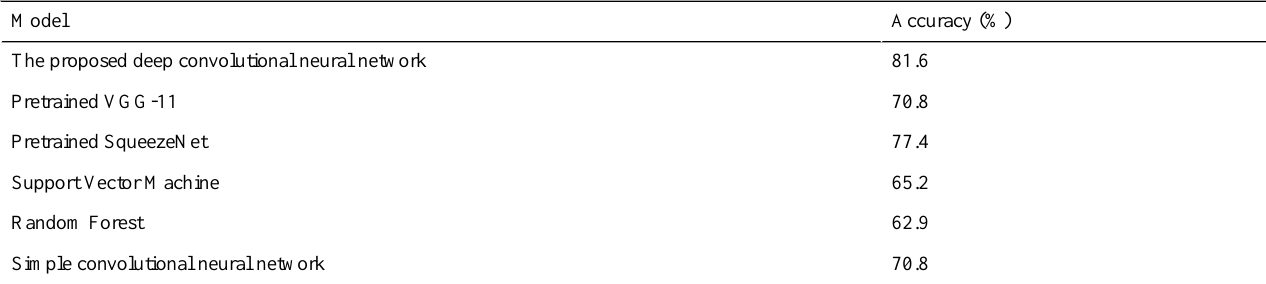
Table 6. Performance comparison of the proposed model and baseline